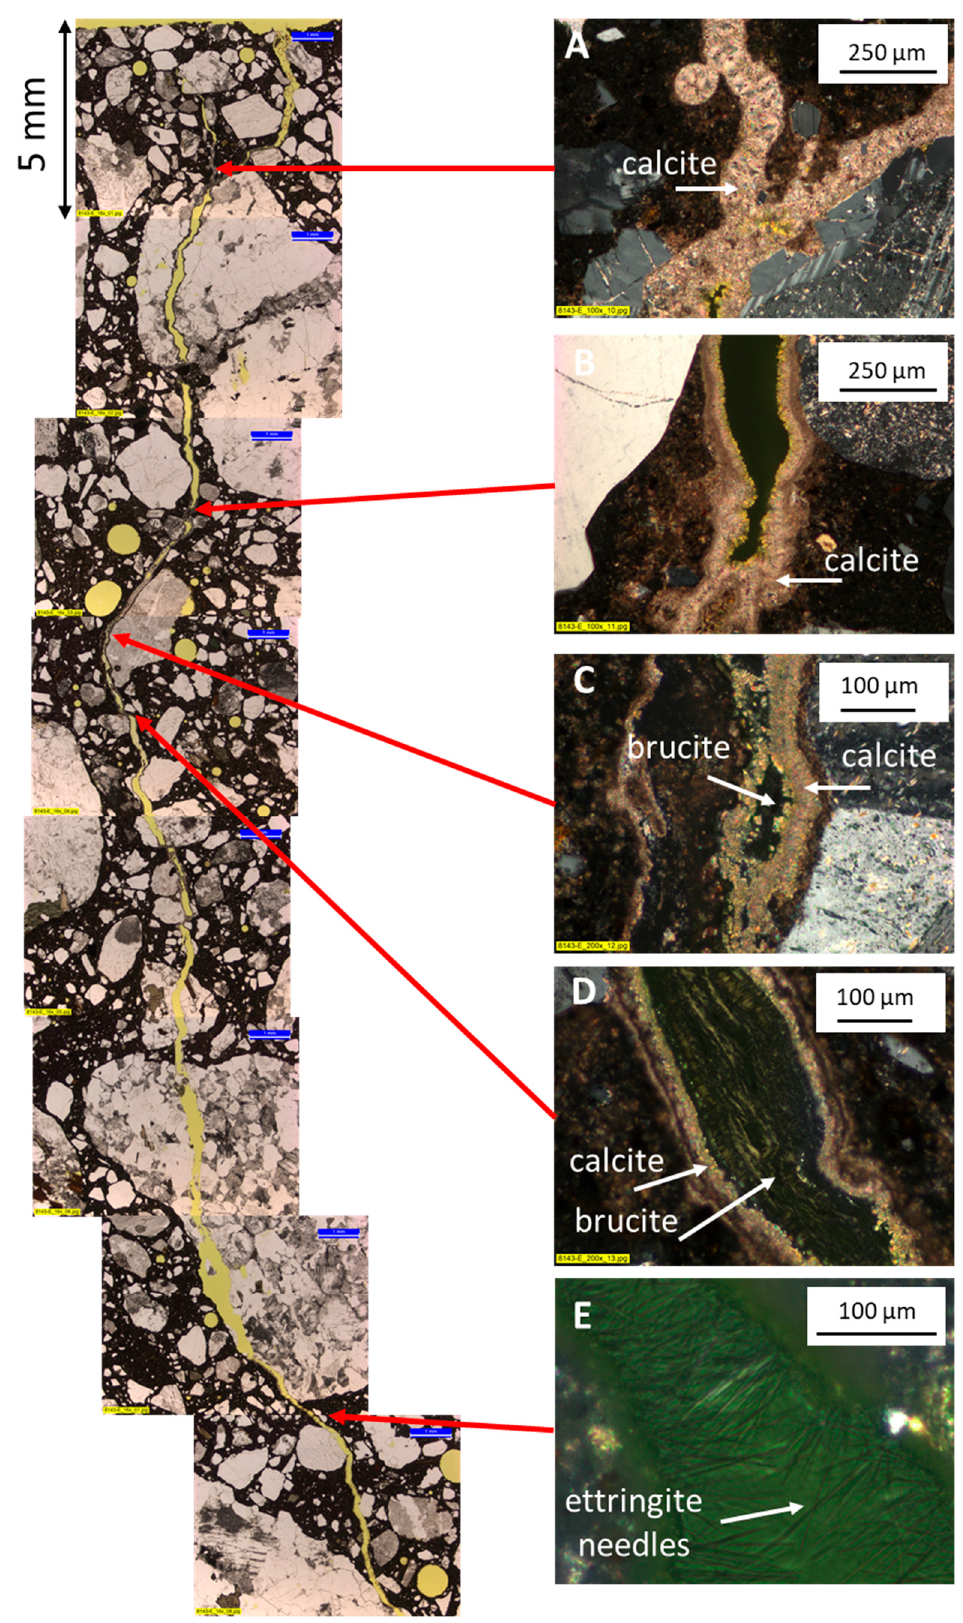
Figure 8. Left: Overview image of the epoxy impregnated crack of PC-4SF20FA until a crack depth of 40 mm, Right: Zoomed in pictures of parts of the cracks showing the variation in self-healing products with crack depth.